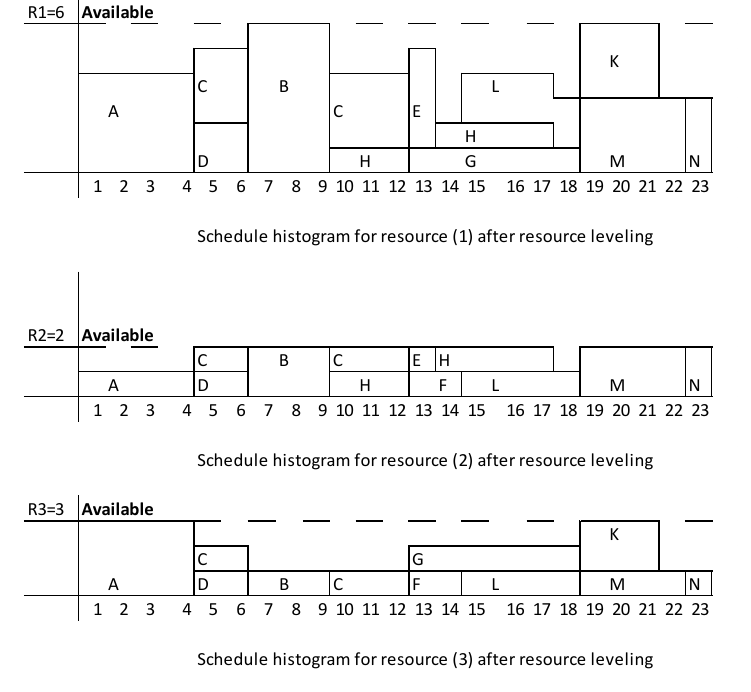
Fig. 15. Project schedule after resources leveling and limitation checking (activity splitting is allowed)